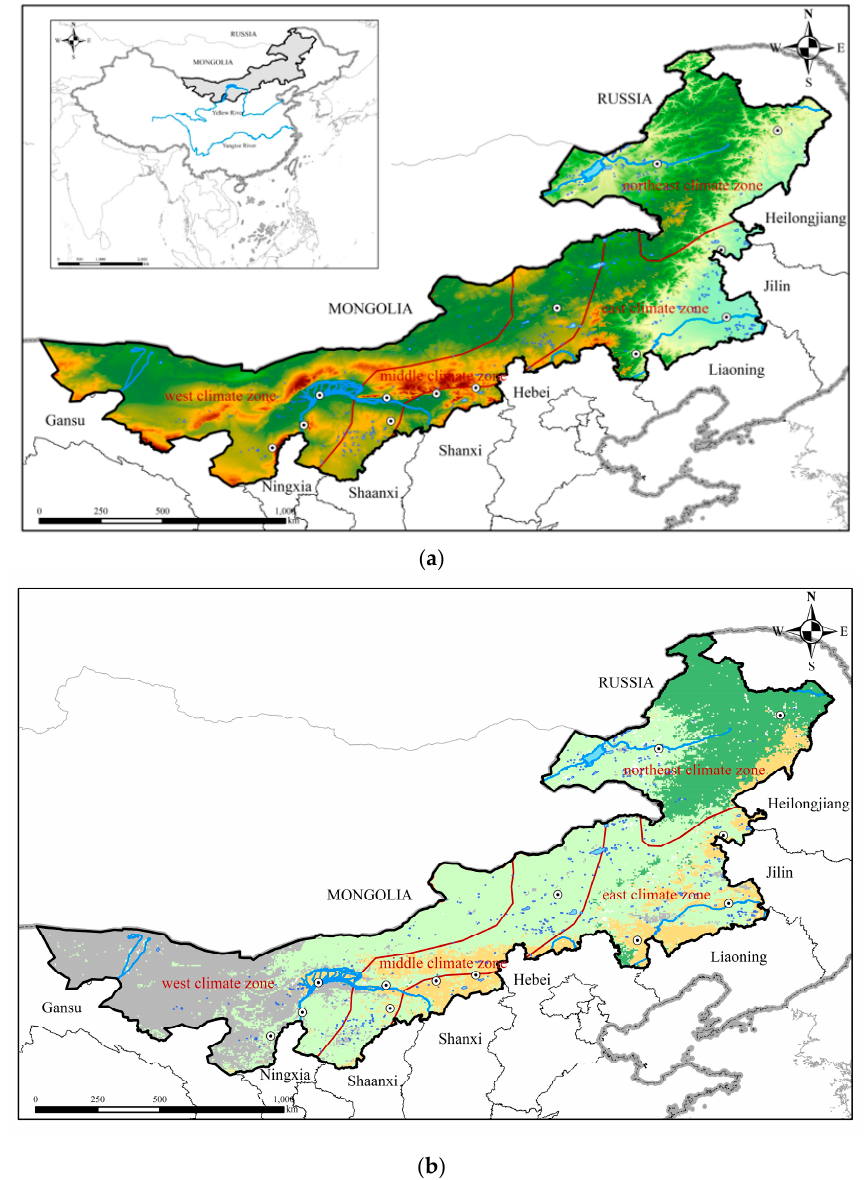
Figure 1. Location ( a ) and land cover ( b ) of Inner